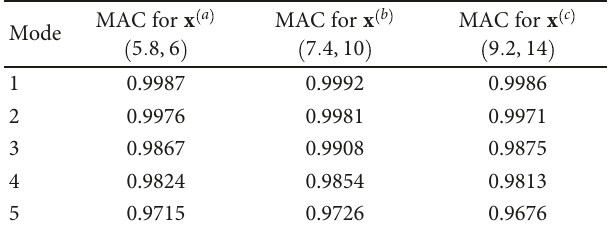
Table 1: MAC value associated with each mode